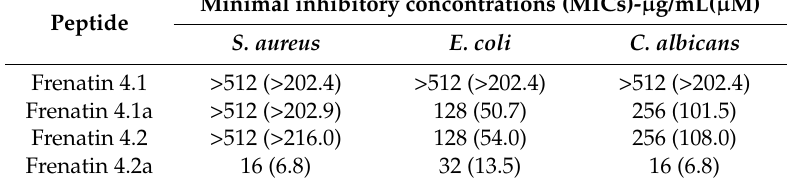
Table 2. Minimal inhibitory concentrations (MICs) of the frenatin peptides and their analogues as determined for three different test microorganisms. Mass concentration ( μ g/mL) was employed, and molarity ( μ M) was calculated and showed in brackets.